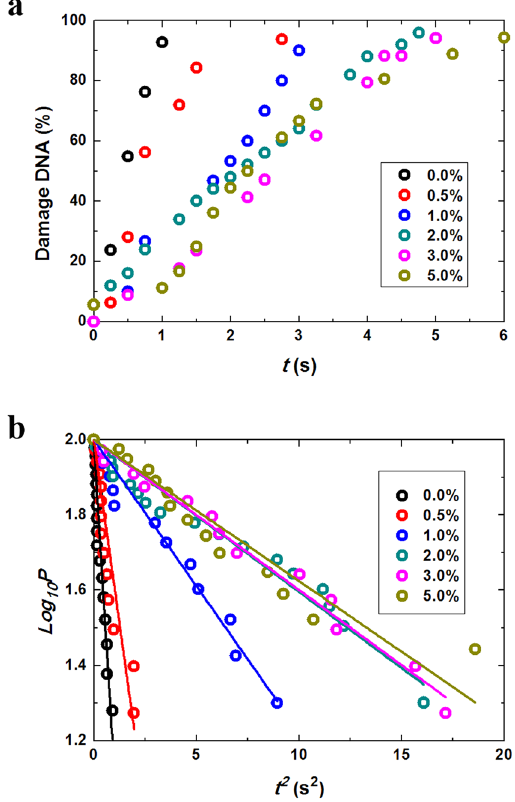
Figure 2. Photo-induced DSBs. ( a ) Time-dependence of the percentage of damaged DNA molecules at different DMSO concentrations. ( b ) The relationship between t 2 and log 10 P , where P is the percentage of surviving DNA molecules, which was calculated as [100% − (percentage of damaged DNA)]. (The kinetic constants, K v ’s (s − 2 ), are evaluated from the slopes of Fig. 2b. For DMSO’s concentration on 2%, 3% and 5%, the slopes are essentially the same within experimental errors, indicating the presence of saturation